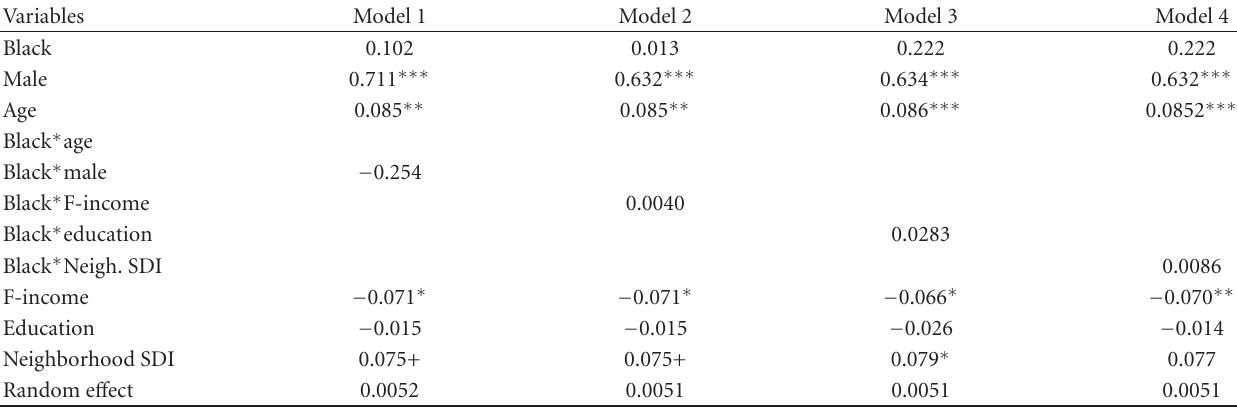
Table 4: The e ff ect of individual SES and neighborhood context on mortality over time (1986–2002) for people aged 65+ at baseline: multilevel survival model (including interactions of race and other